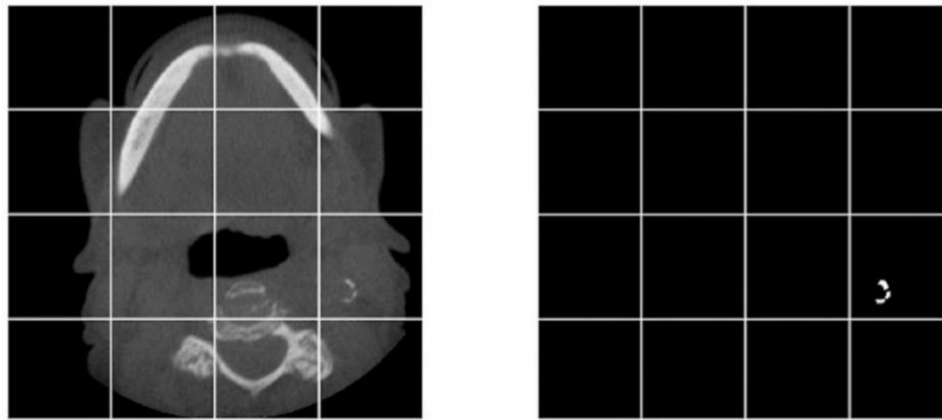
Figure 3. A sample of dividing an image and its corresponding mask into smaller pieces for training the neural network.